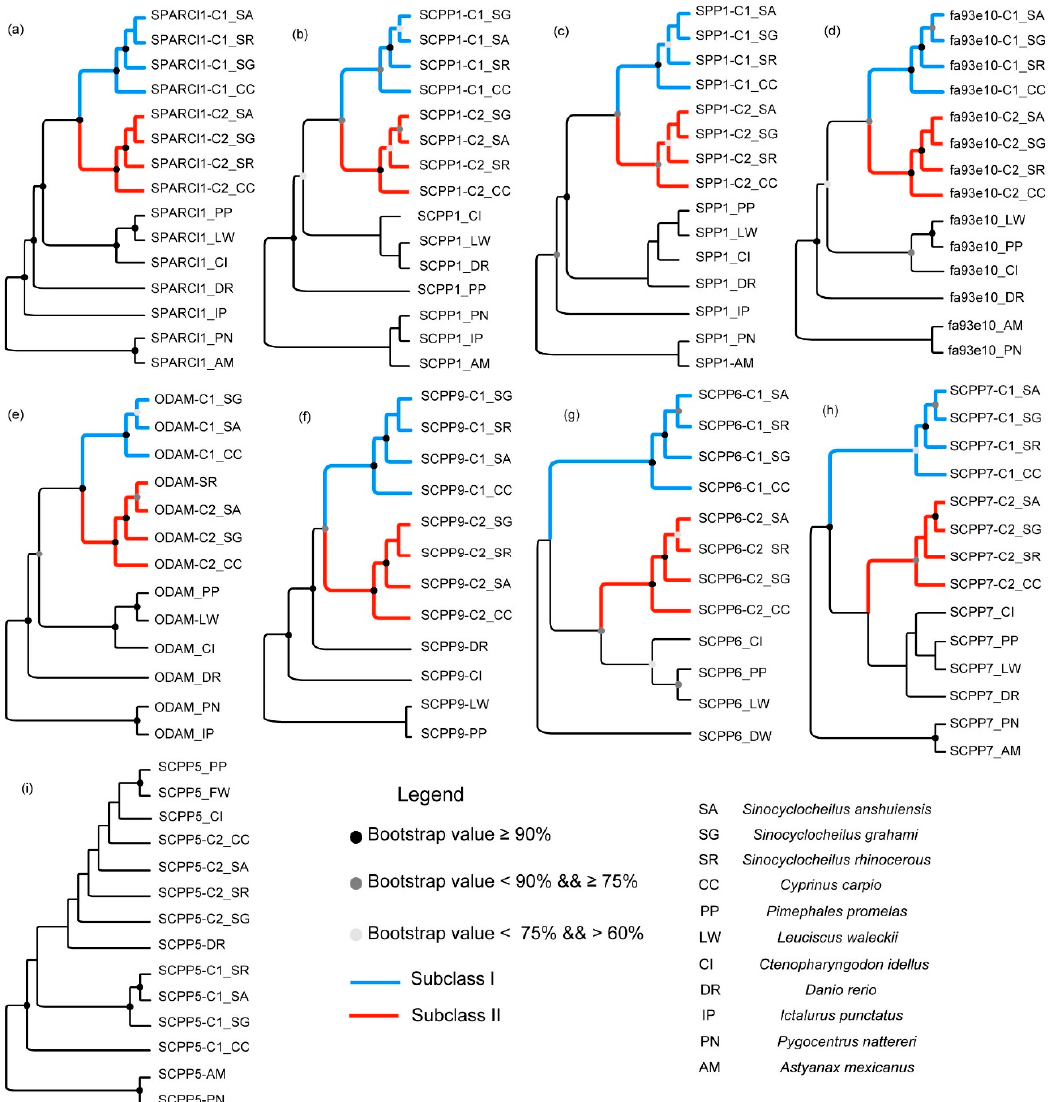
Figure 2. Phylogeny of SPARCL1 and eight SCPP family genes among 11 fish species. The sequences from zebrafish ( Danio rerio ; DR) were downloaded from NCBI (find detailed accession numbers in Table S1) for subsequent homology searching, and other sequences were extracted from corresponding genomes. ( a – i ) The phylogenic topology of SPARCL1 , SCPP1 , SPP1 , fa93e10 , ODAM , SCPP9 , SCPP6 , SCPP7 , and SCPP5 , respectively. The blue and red shaded branches mark Subclasses I and II, respectively, among the two gene copies within CC, SA, SR, and SG. The phylogenetic analysis using maximum likelihood (ML) methods was performed, replicated 1000 times, to evaluate their branch supports, which are displayed as circles in the nodes when higher than 60%.